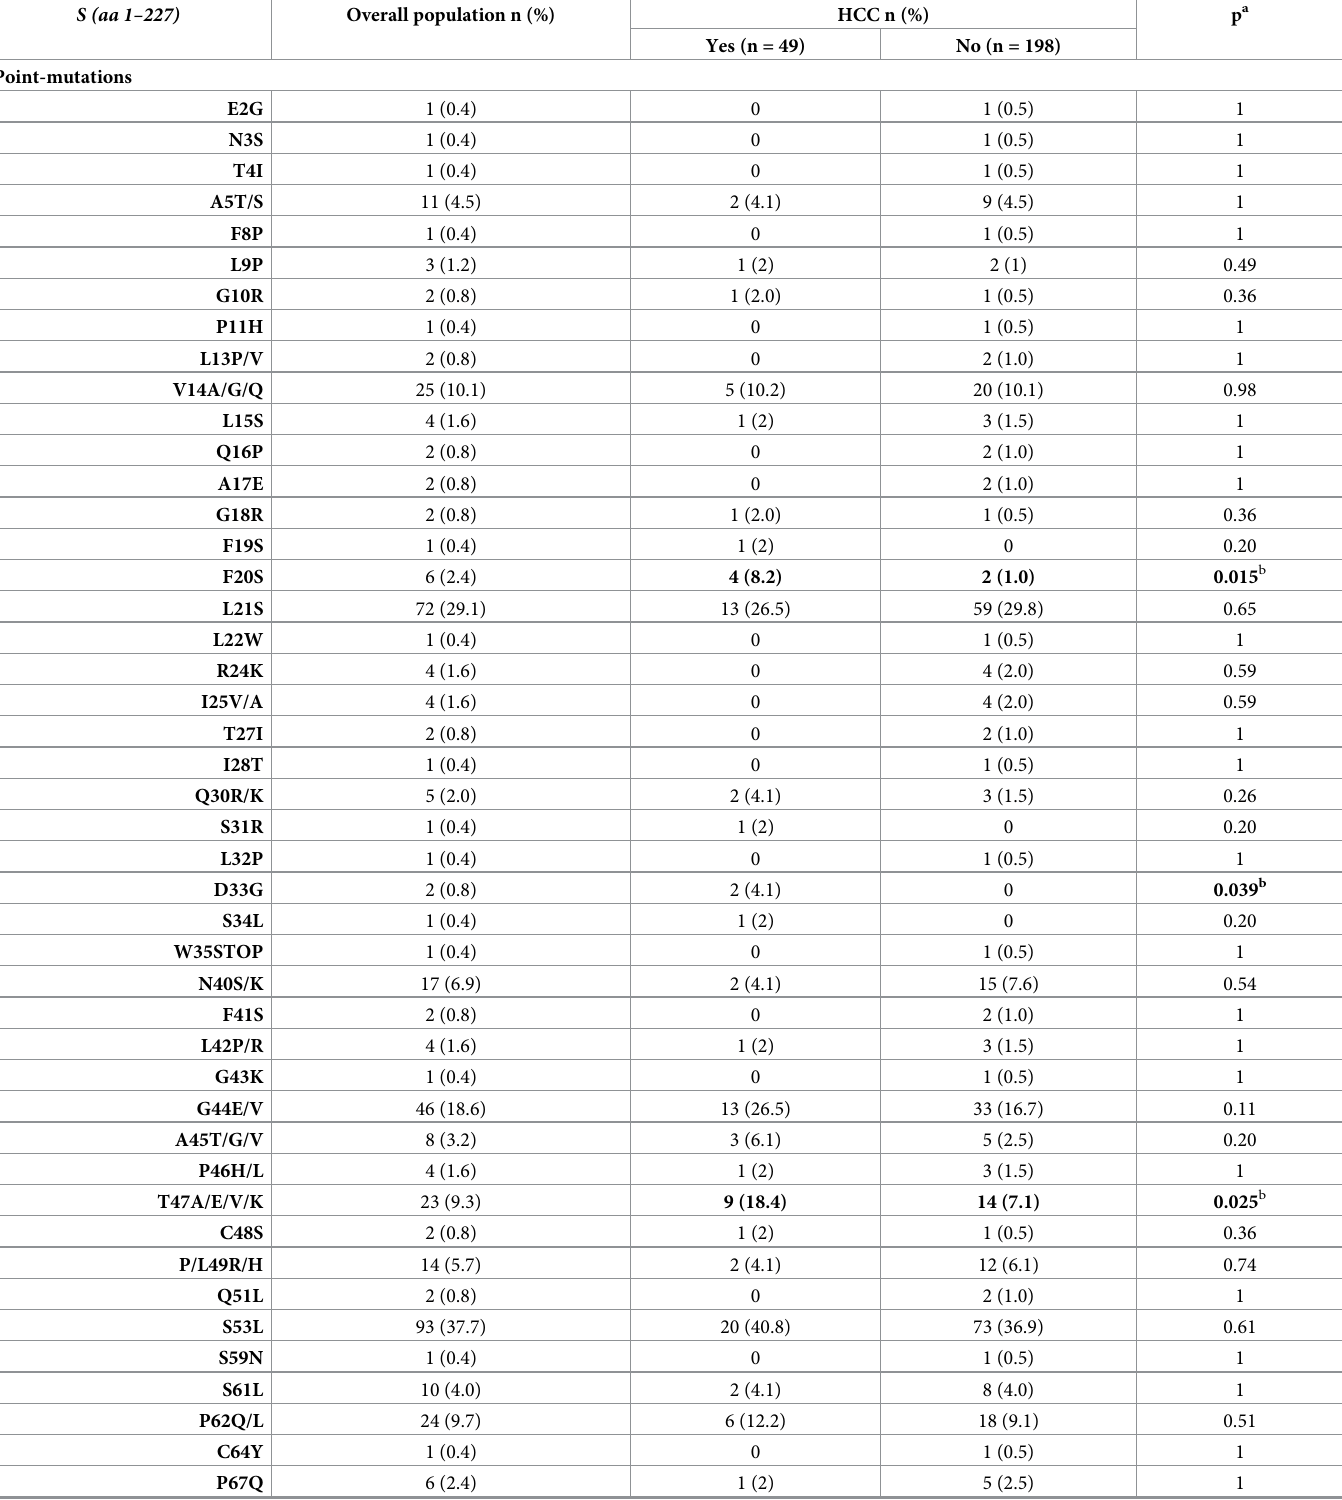
Table 4. Distribution of point-mutations on the S gene (n = 247). S (aa